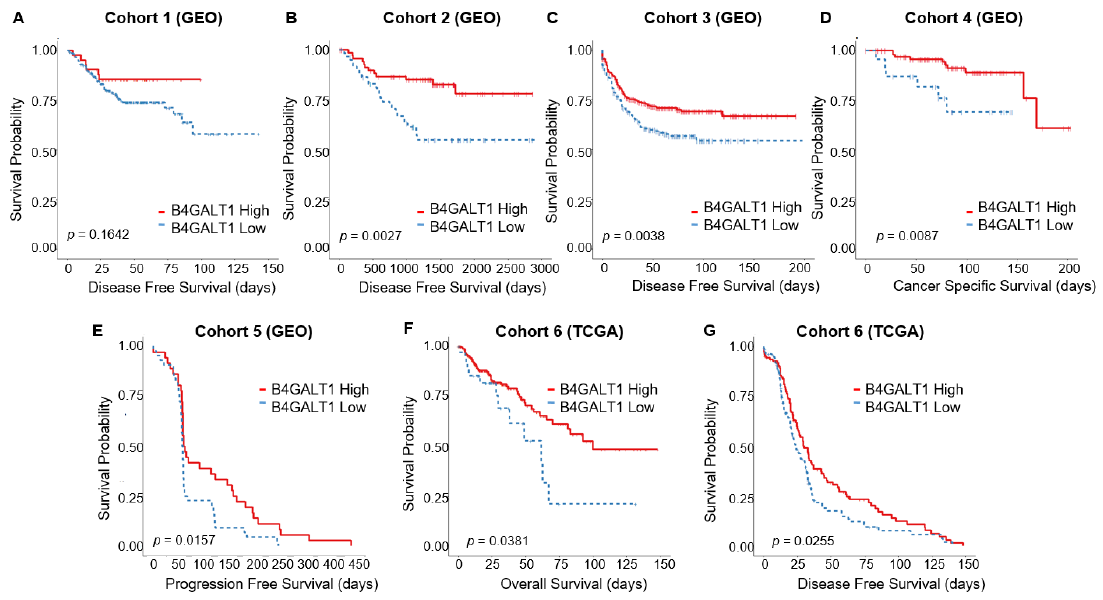
Figure 2. Kaplan–Meier survival curves of B4GALT1 high (red line) and low (blue line) expression groups in GEO and TCGA cohorts 1–6. ( A ) Disease-free survival (DFS) in GEO Cohort 1 ( n = 226), ( B ) DFS in GEO Cohort 2 ( n = 130), ( C ) DFS in GEO Cohort 3 ( n = 557), ( D ) cancer-specific survival (CSS) in GEO Cohort 4 ( n = 125), ( E ) progression-free survival (PFS) in GEO Cohort 5 ( n = 80), ( F ) overall survival (OS) in TCGA Cohort 6, ( G ) DFS in TCGA Cohort 6 ( n = 300).